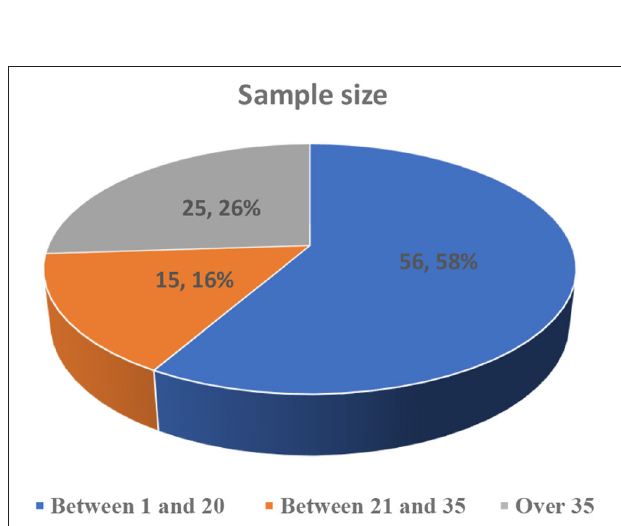
FIGURE 4 | Distribution of studies based on sample